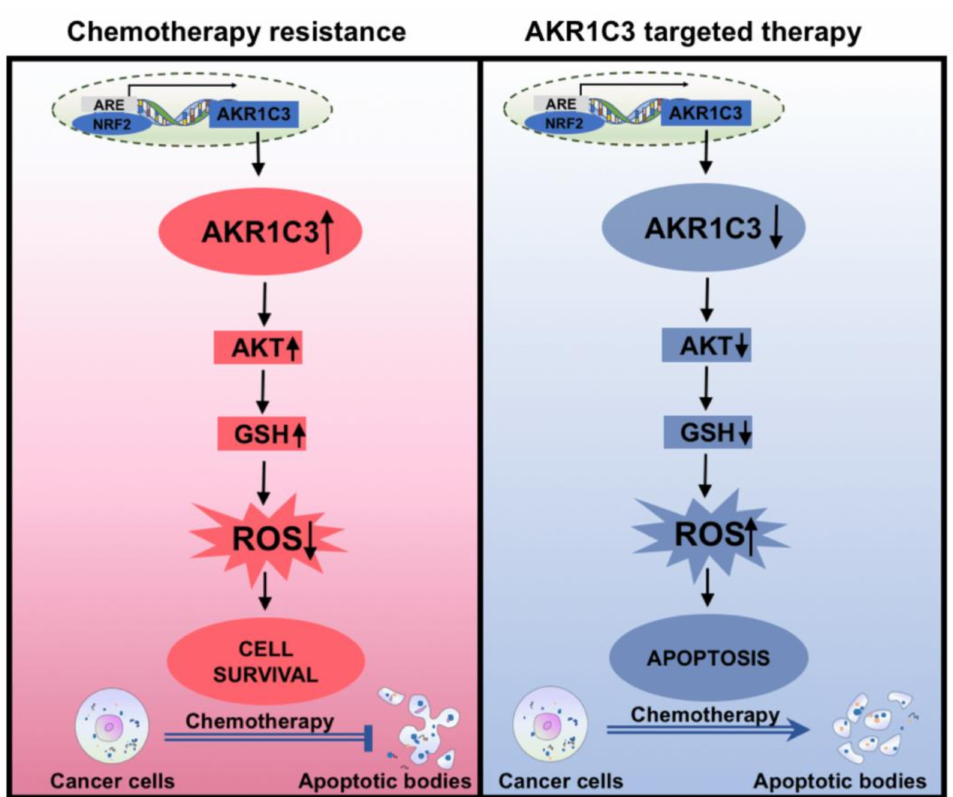
Figure 6. Schematic picture of AKR1C3 regulating intracellular ROS levels and protecting EAC cells from chemotherapy-induced apoptosis.